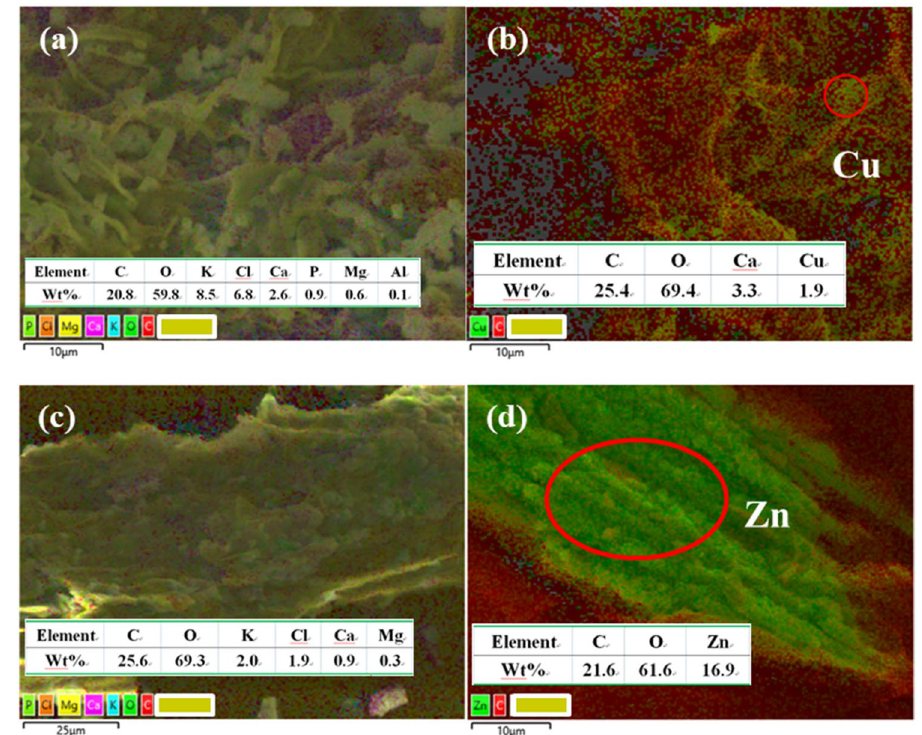
Figure 9. EDX layered images of ( a ) Cu-BC; ( b ) Cu-BC + Cu; ( c ) Zn-BC and ( d ) Zn-BC + Zn.